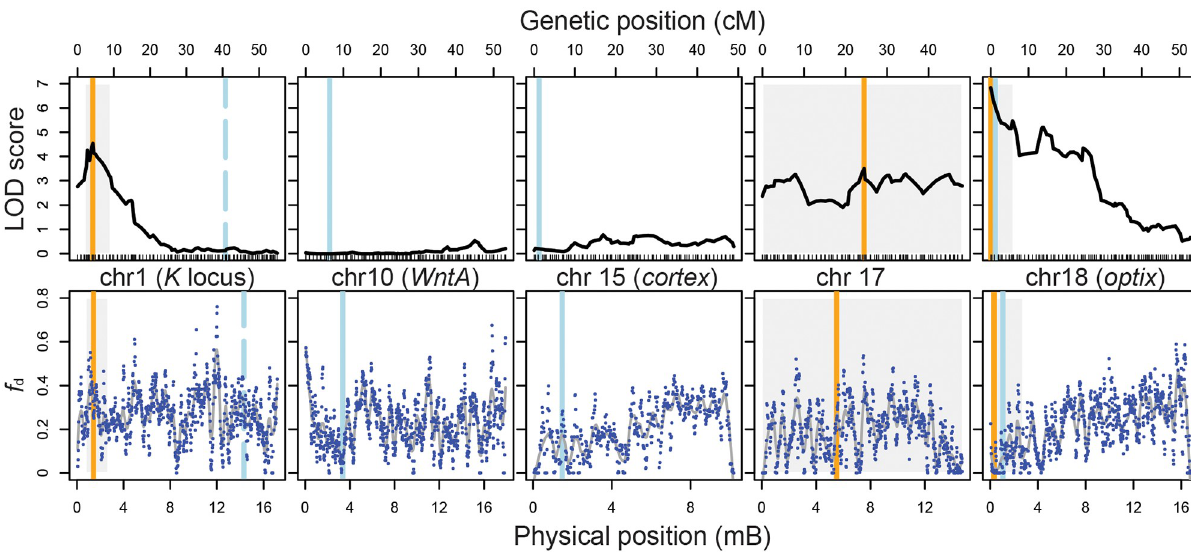
Fig 3. Genetic and physical positions of behavioral QTL and the warning pattern loci and localized levels of admixture ( f d ). Vertical blue lines represent the position of major color pattern loci and orange lines represent the position of peak LOD score for each behavioral QTL. Gray boxes indicate the 1.5-LOD support interval for each QTL. Top panel: Dashes along the x-axis indicate position of genetic markers (SNPs). Bottom panel: Blue points represent f d values for 100-kb windows. f d was measured between H . melpomene rosina and H . cydno chioneus individuals from population samples in Panama; H . melpomene melpomene from French Guiana, which is allopatric with respect to H . cydno , was the “control” population. Underlying data can be found in the online Dryad repository doi.10.5061/dryad.4b240j4, specifically raw_data/data_for_Rqtl.csv, derived_data/ genome_scan_lod_score.csv, and raw_data/fd_values_SM_2MAY18/ /bar92.DP8MP4BIMAC2HET75.fourPopPol_melG_melW_cyd_num.